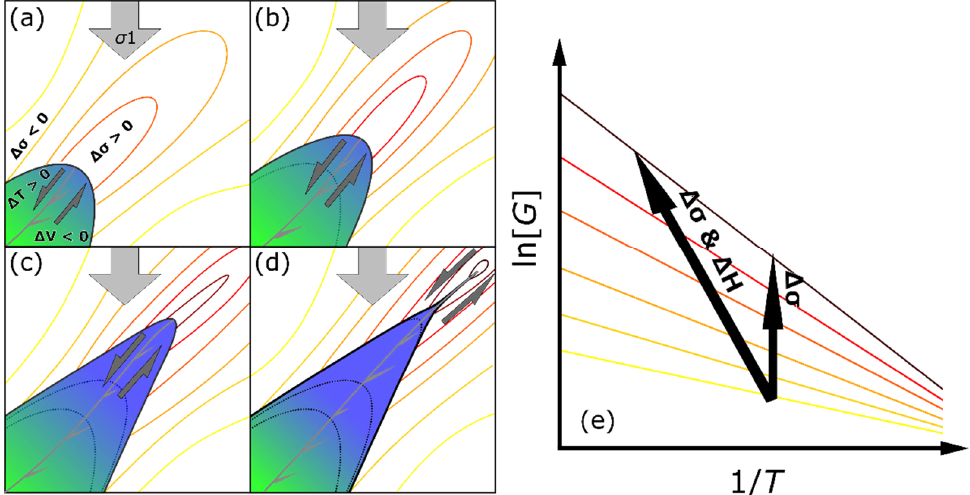
Figure 18. Schematic growth of an anti-crack type shear band. ( a–d ) represent successive stages of growth. Principal stress is vertical. The blue and green region in the left bottom corner represents the partly reacted shear band, with the direction of shear depicted by the half-headed arrows. Lines in yellow to red colors depict increasingly high stress levels. Gray lines illustrate a fault that propagates over increasingly long distances as the shear band grows. ( e ) qualitatively depicts effects of local stress change at the tip of the shear band according to Equation (4). The vertical arrow represents an increase in growth rate due to a mere stress concentration. The diagonal arrow shows that a much larger growth rate increase may be obtained when considering latent heat release due to local temperature rise.